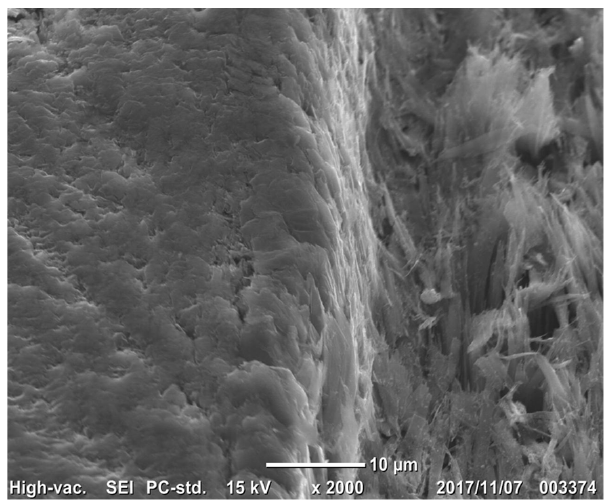
Figure 6. SEM image on the micro-textured VGS after oxygen plasma etching for 7.2 ks.